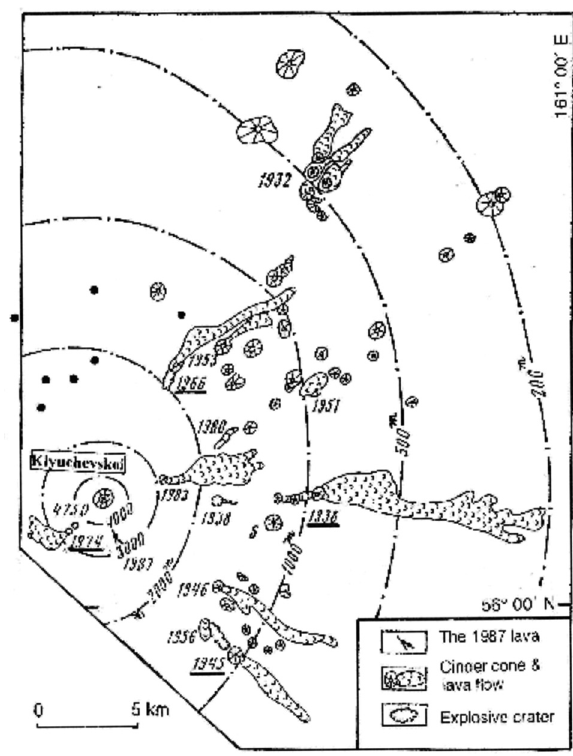
Figure 15. Distribution of parasitic vents on Klyuchevskoi volcano after Fedotov et al. [1990]. Chain lines are height contours in meter above the sea level. Klyuchevskoi continues to extinct volcano Kamen at the SW